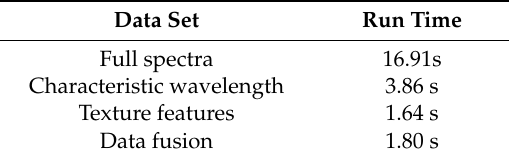
Table 5. Run time of the BPNN models based on different data